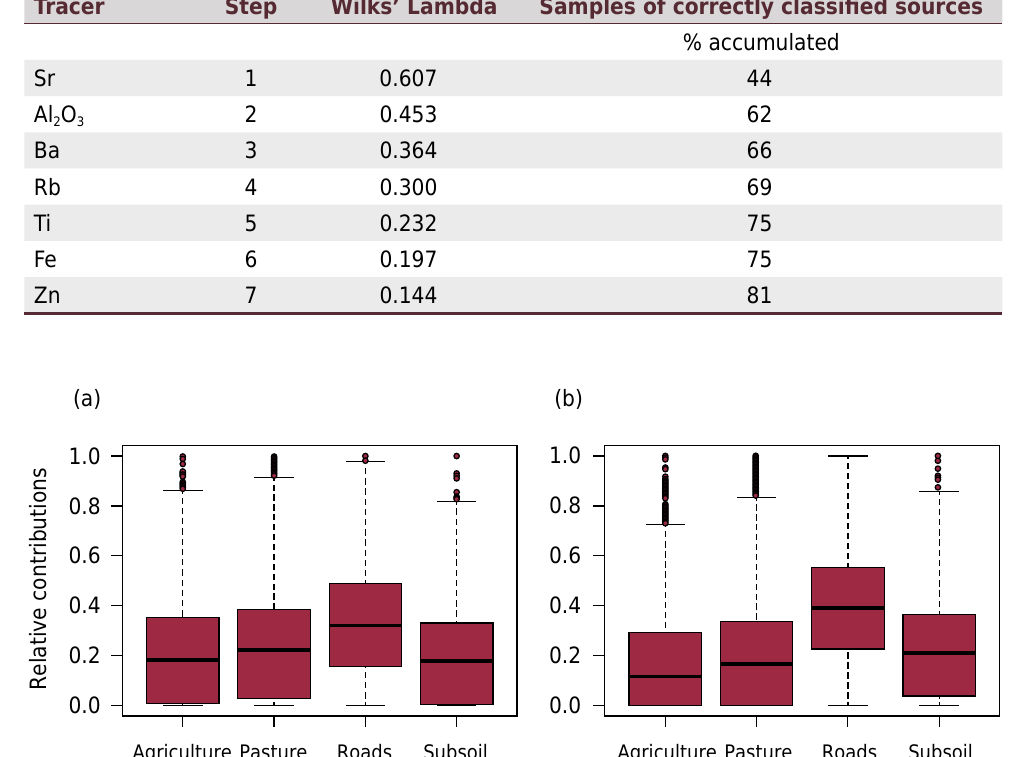
Table 3. Set of tracers able to discriminate the sediment sources in relation to land use in the Posses catchment, selected through a discriminant function using Wilks’ Lambda in a stepwise procedure Tracer